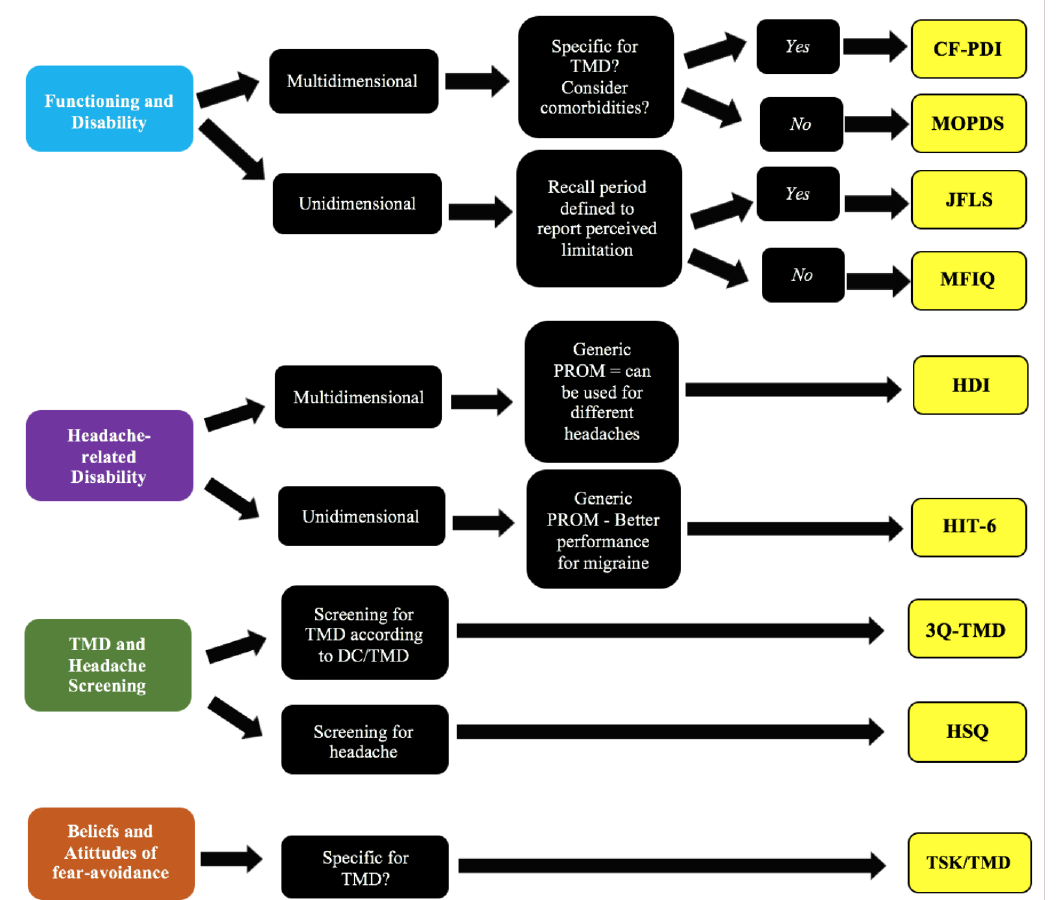
Figure 2. Diagram illustrating the process to choose the suitable Patient Reported Outcome Measure. Legends: PROM: Patient Reported Outcome Measure, TMD: Temporomandibular Disorders, DC/TMD: Diagnostic Criteria for Temporo- mandibular Disorders, MFIQ: Mandibular Function Impairment Questionnaire (MFIQ), CF-PDI: Craniofacial Pain and Disability Inventory, JFLS: Jaw Functional Limitation Scale, MOPDS: Manchester Orofacial Pain Disability Scale, HDI: Headache-Related Disability Index, HIT-6: Headache Impact Test-6, 3Q-TMD: Three screening questions for Temporo- mandibular Disorders (3Q/TMD), HSQ: Headache Screening